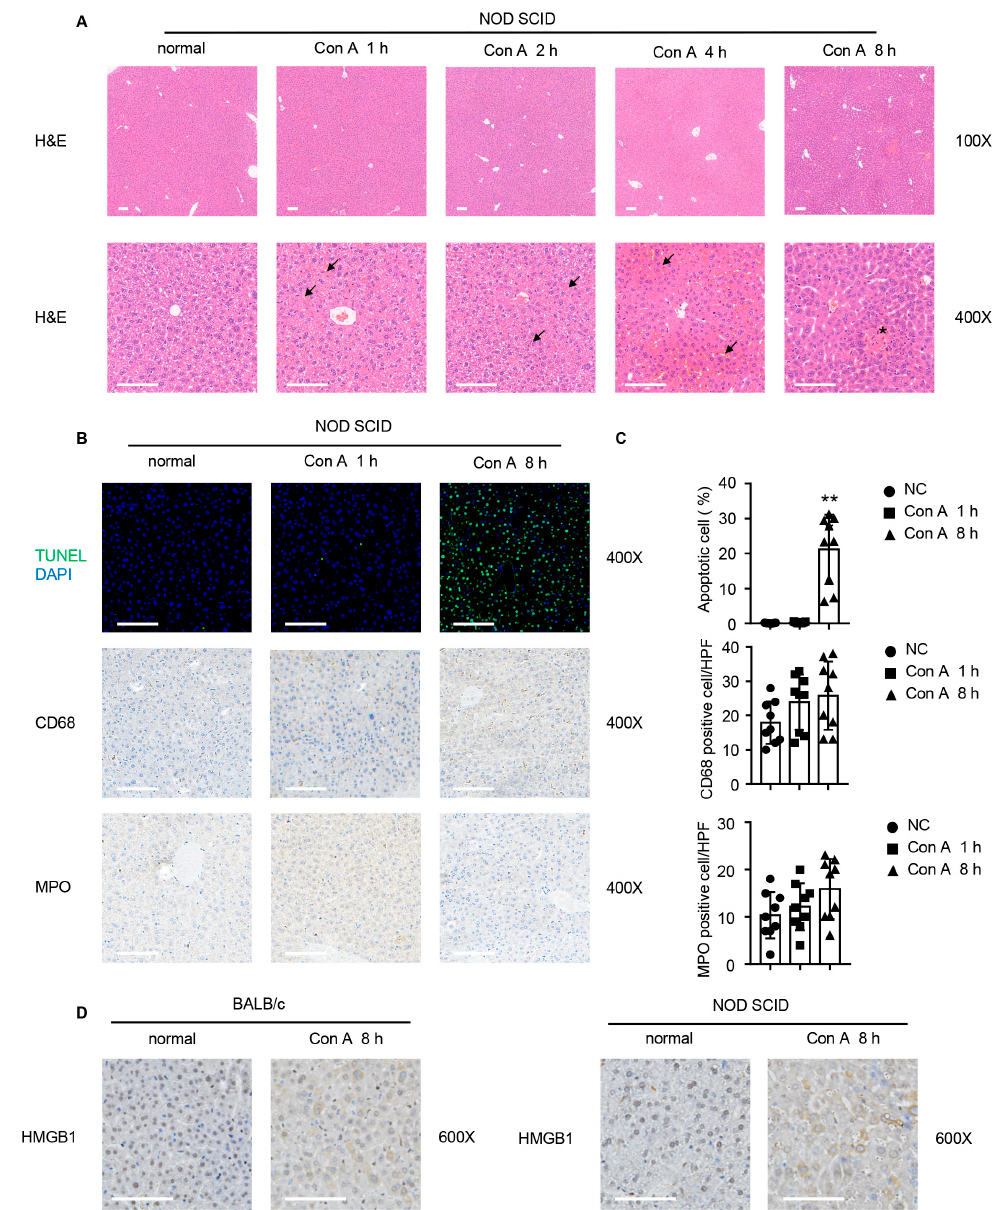
Figure 2. Con A-injected NOD SCID mice exhibit histological changes typical of liver injury. Liver tissues were obtained from NOD SCID or BALB/c mice that had been injected with Con A (25 mg/kg of body weight) or saline solution at the times indicated. ( A ) Histopathological changes in the liver were detected by hematoxylin and eosin (H&E) staining, and representative images are shown (magnification: 100× and 400×). The triangles indicate congestion in the liver tissue, and the asterisk indicate bridging coagulative death of hepatocytes. Scale bar, 100 μ m. ( B ) Immunofluorescence was applied to detect the cells that were positively stained by TUNEL in livers from NOD SCID mice, with or without Con A administration at indicated time points (upper panel). Immunohistochemical images of staining for CD68 (middle panel) and MPO staining (lower panel) in liver tissue from NOD SCID mice are shown (magnification: 400×). Scale bar, 100 μ m. ( C ) Bar graphs depict the percentage of TUNEL positively staining cells (upper panel), and cell counts for CD68 staining (middle panel), and MPO staining (lower panel) per HPF ( n = 9 for each group). Each symbol represents one individual. ( D )Immunohistochemical analysis of HMGB1 in NOD SCID mouse liver sections 8 h after Con A or vehicle administration (magnification: 600×). Scale bar, 100 μ m. Bar graphs show means ± SD. **, p < 0.01, vs. the normal group.